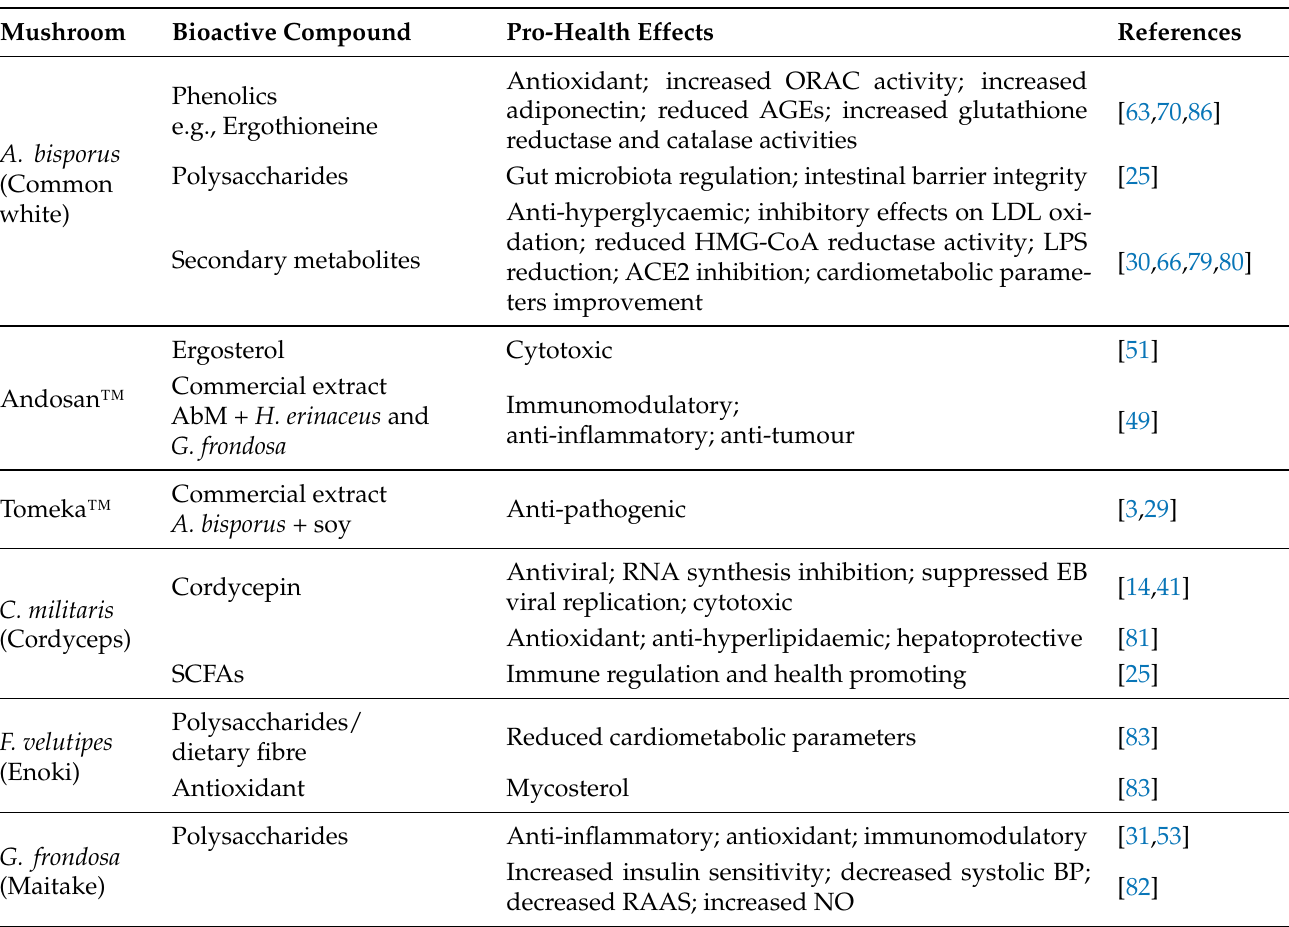
Table 1. Research findings for specific mushroom species demonstrating beneficial effects and activities for potential pro-health therapeutic